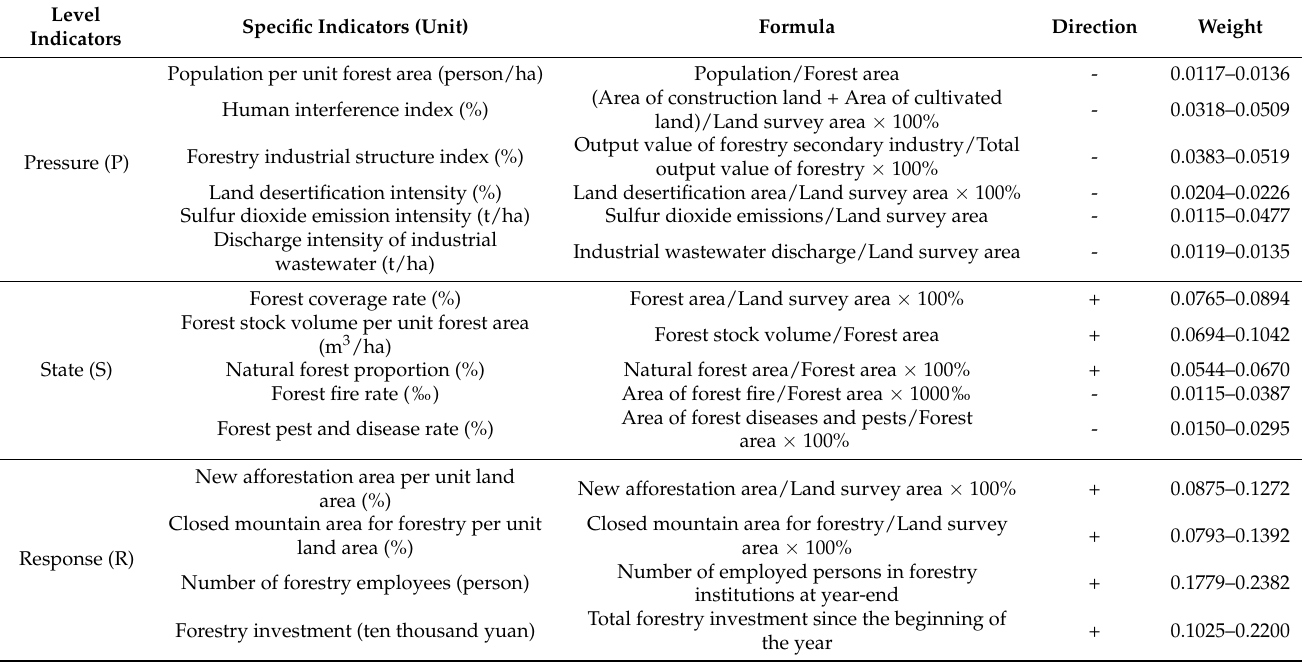
Table 1. The evaluation index system of forest ecological